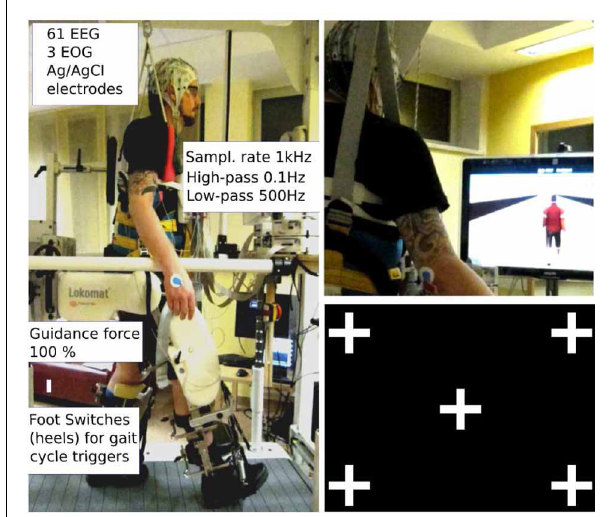
FIGURE 1 | Experimental setup: subject walking in the lokomat gait orthosis with body weight support. The amplifiers for EEG recordings are fixed on a board in front of the participant. The orthosis is adapted and fixed to the participant’s legs with the help of an experienced physical therapist; Left: robotic assisted walking. Speed ( ≤ 2.2km/h) and body weight support ( ∼ 30%) were adjusted for each participant; Right top: participant walking in the 3rd person VE condition. Right bottom: gaze screen with possible locations for the graphical